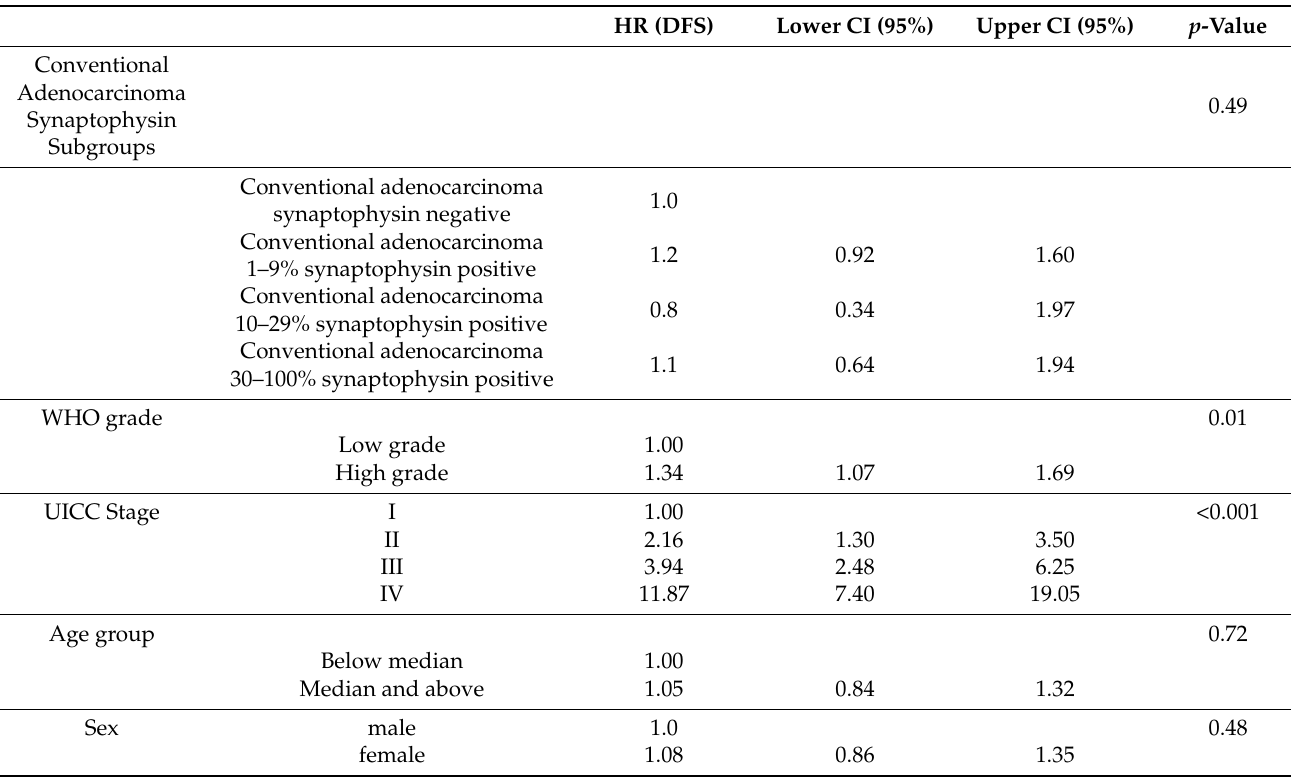
Table 2. Multivariate analysis for disease-free survival including synaptophysin expression groups in conventional adenocarcinomas with a non-neuroendocrine morphology, UICC stage, WHO grade, age and sex. HR (DFS) Lower CI (95%)